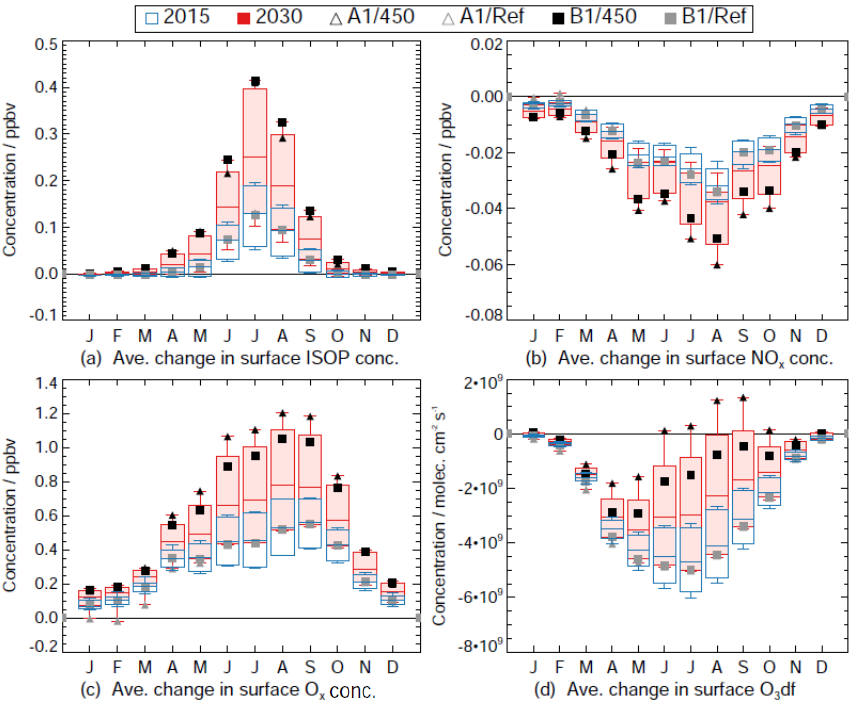
Fig. 12. Same as Fig. 7 but for China (Fig.